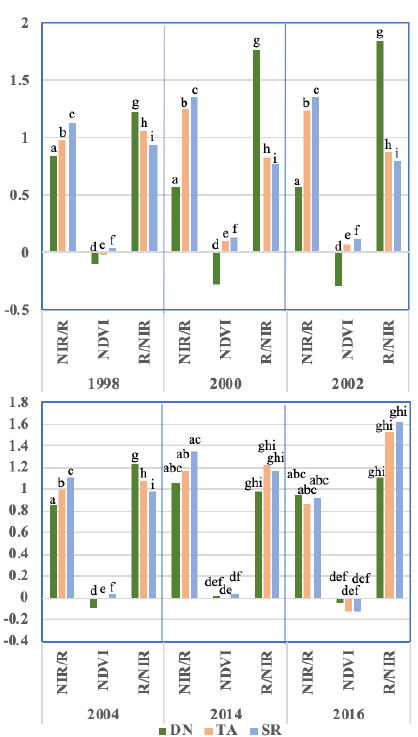
Figure 9. Average values of the Water Impoundment Index (WII), Modified Water Impoundment Index (MWII), Water Index (WI), and Modified Water Index (MWI) of edge water for three pre-processing levels (DN, TA, SR) across six